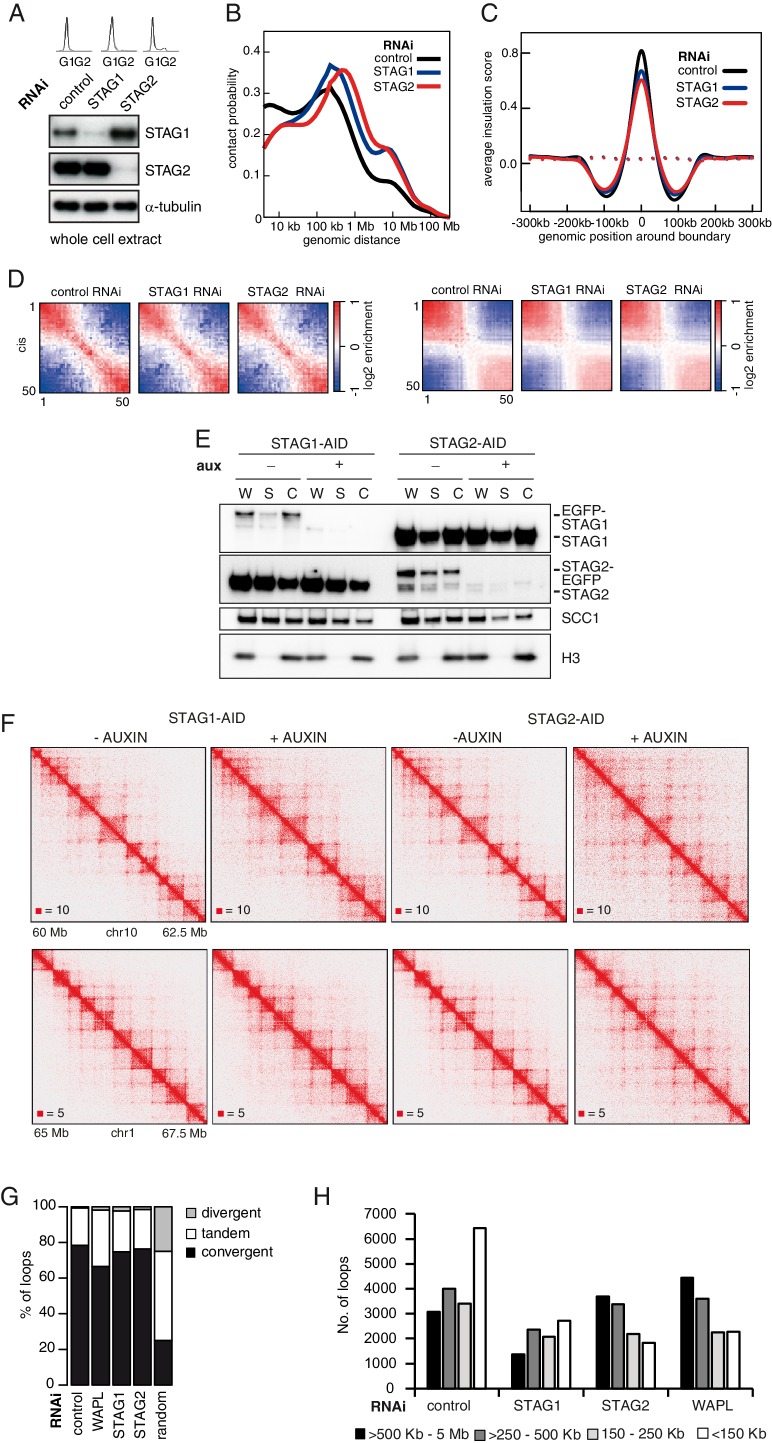
CohesinSTAG1 generates long chromatin interactions.(A) Flow cytometry and whole cell extract immunoblot analysis of cells synchronized in G1 and depleted of the proteins indicated. α-tubulin was used as a loading control. (B) Intra-chromosomal contact frequency distribution as a function of genomic distance using logarithmically increasing genomic distance bins, for control-, STAG1- and STAG2-depleted HeLa cells. (C) Average insulation score around TAD boundaries in control-, STAG1- and STAG2-depleted HeLa cells synchronized in G1. Dashed lines indicate the average insulation score between random positions. (D) Long range (>2 Mb) intra-chromosomal (cis) and inter-chromosomal (trans) contact enrichment between bins with varying compartment signal strength from most B-like (1) to most A-like (50). (E) Immunoblot analysis of STAG1- and STAG2-AID cell lines. Immunoblotting of whole cell (W), soluble (S) and chromatin (C) extracts was performed using the STAG1, STAG2 and SCC1 antibodies. Histone H3 was used as a loading control. (F) Coverage-corrected Hi-C matrices of chromosome 10 (60–62.5 Mb) and chromosome 1 (65–67.5 Mb) from STAG1- and STAG2-AID cell lines with and without auxin treatment Matrices were plotted using Juicebox. (G) The proportion of convergent, tandem and divergent CTCF binding orientation for loops with both anchors overlapping SMC3 and CTCF ChIP-seq peaks as well as unambiguous CTCF binding directions, for loops identified in control-depleted cells in G1-phase (ctrl, 4933 loops), in WAPL depleted but not in control-depleted cells in G1-phase (WAPL, 1898 loops), in STAG1 depleted but not in control-depleted cells in G1-phase (STAG1, 428 loops) and STAG2 depleted but not in control-depleted cells in G1-phase (STAG2, 1229 loops) (Hi-C maps 1,2,3 and 4 in Supplementary file 1 were down-sampled to 314 million reads). The theoretically expected random proportions assuming no directionality bias are shown as comparison. (H) Distribution of loop length in control-, STAG1-, STAG2- and WAPL-depleted HeLa cells (1,2,3 and 4 in Supplementary file 1 were down-sampled to 314 million reads). Loops were identified by hiccups.